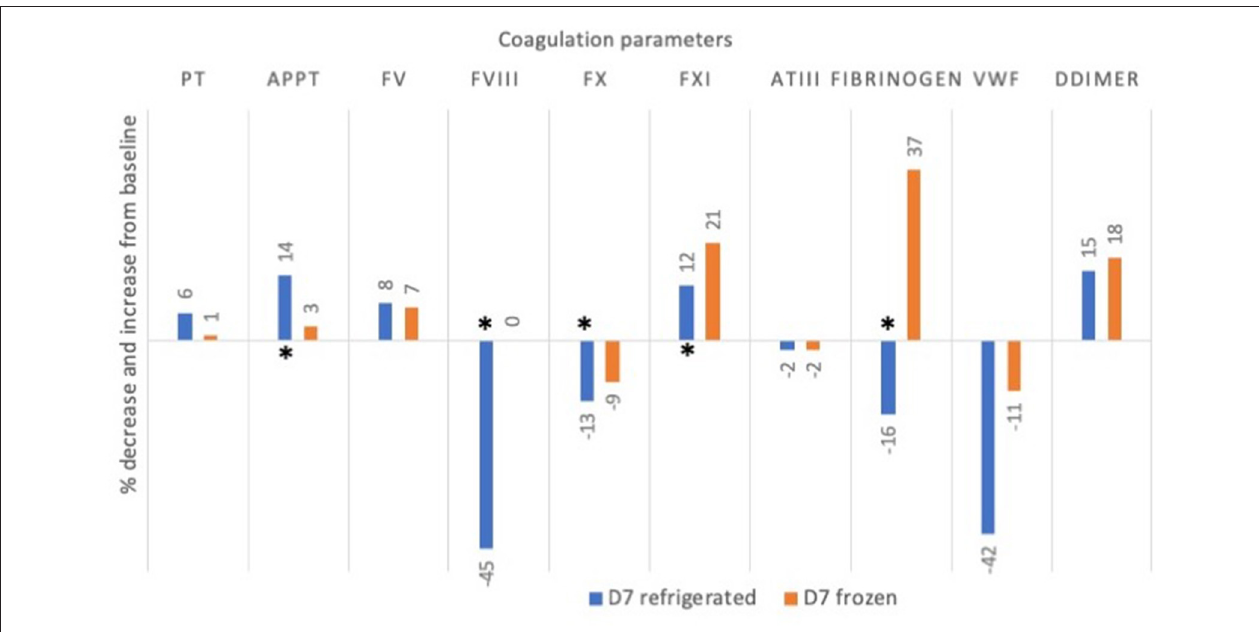
FIGURE 2 | Mean percentage change (decrease or increase) in coagulation factor activities and times in 5 canine plasma units after 7 days of storage refrigerated or frozen. Asterisks * denote significant differences ( p < 0.05) as compared to baseline value at D0. PT, prothrombin time; aPTT, activated partial thromboplastin time; FV, factor V, FVIII, factor VIII; FX: factor X; FXI, factor XI; AT, antithrombin; vWF, von Willebrand